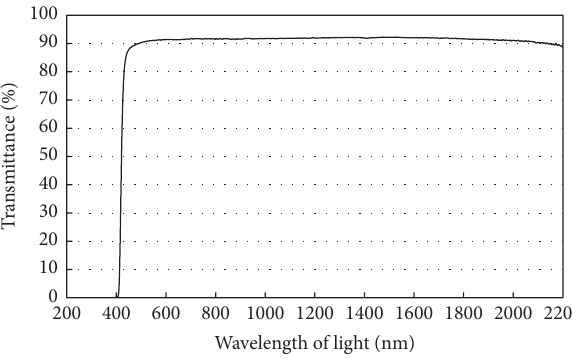
Figure 3: Light transmittance data of sharp cut